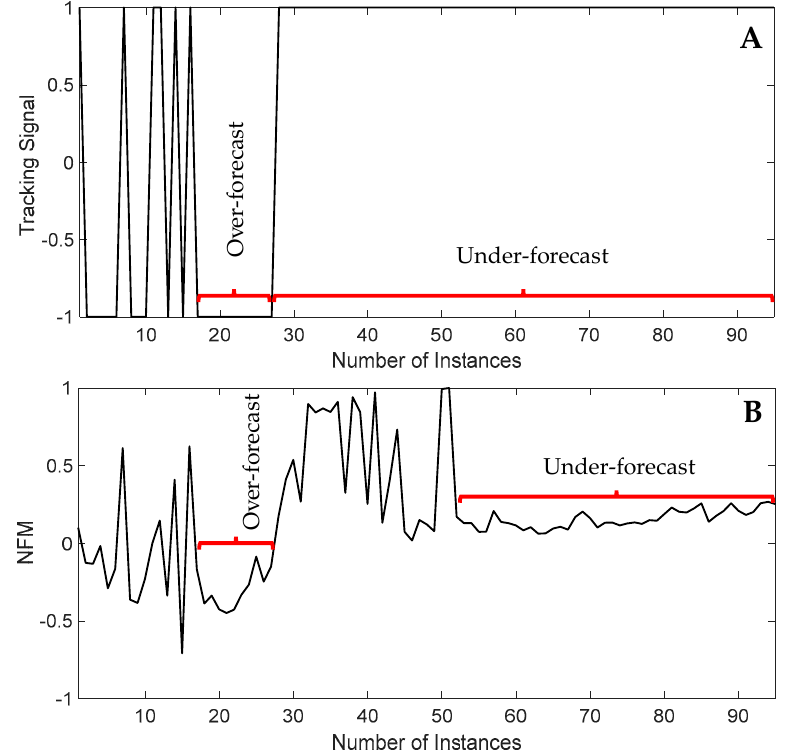
Figure 9. Bias calculation for a biased prediction for all features based PV power prediction: ( A ) Using tracking signal technique; ( B ) using NFM technique.